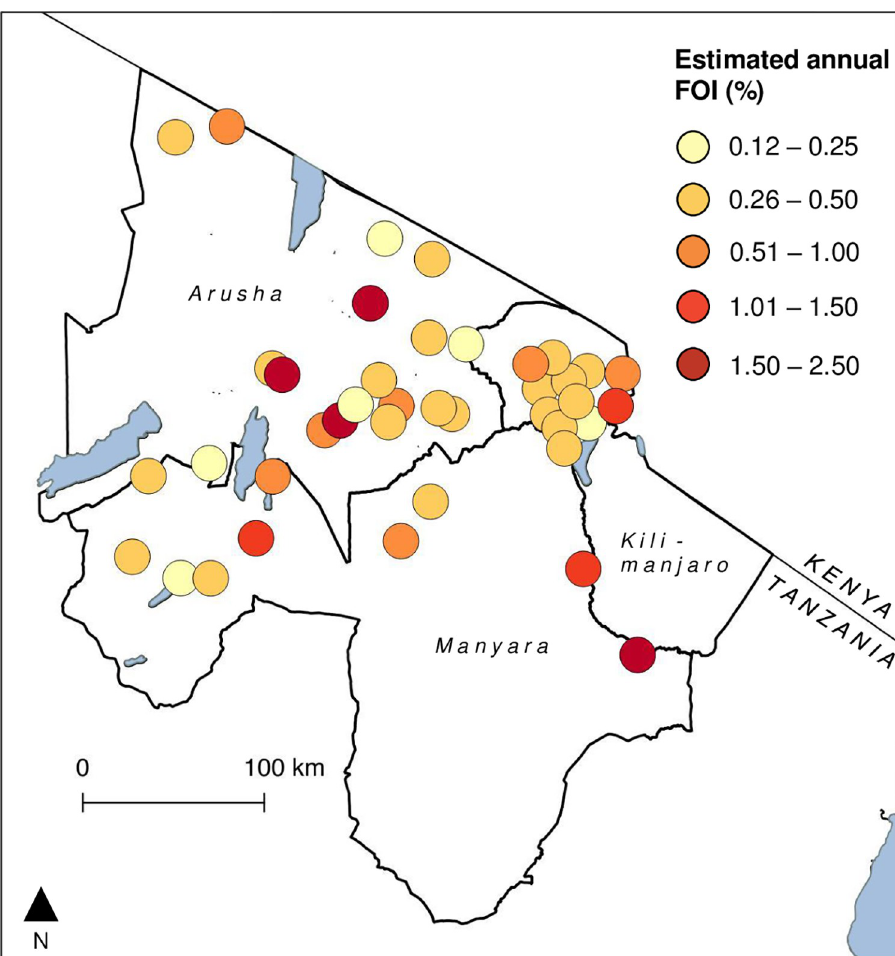
Fig 3. Variation in the village-level annual predicted force of infection (FOI) of Rift Valley fever virus among livestock between 2009 and 2015 in Arusha, Manyara and Kilimanjaro Regions of northern Tanzania. Map created using QGIS version 3.22.1. Base layer from GADM (https:gadm.org/).